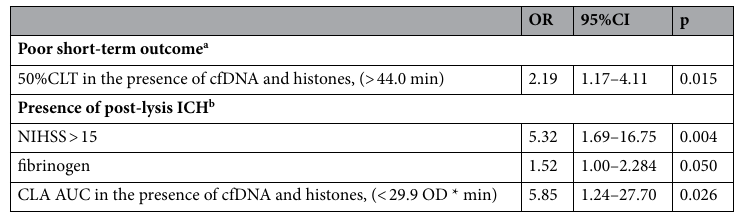
Table 6. Independent predictors of poor short-term outcome and post-lysis intracranial hemorrhage in the studied cohort. Last step of backward multiple regression analysis is provided. cfDNA, cell-free DNA; CLA AUC, clot lysis assay area under the curve parameter; 95%CI, 95% confidence interval; 50%CLT, 50% clot lysis time; ICH, intracranial hemorrhage; NIHSS, National Institutes of Health Stroke Scale; OR, odds ratio. a Poor short-term outcome is defined as a less than 4 points decrease or any increase of NIHSS by day 7 post-event, excluding patients with intracranial hemorrhage. Backward multiple regression model included age, sex, NIHSS on admission, BMI, fibrinogen, D-dimer, plasminogen activity, α2-plasmin inhibitor activity, 50%CLT (threshold: > 45 min) 50%CLT in the presence of cfDNA and histones (threshold: > 44 min), CLA AUC (threshold: > 27.7 OD * min), CLA AUC in the presence of DNA and histones (threshold > 25.4 OD * min). b Backward multiple regression model included age, sex, NIHSS on admission, BMI, history of arterial hypertension, history of hyperlipidemia, fibrinogen, D-dimer, plasminogen activity, α2-plasmin inhibitor activity, 50%CLT (threshold: < 39 min), 50%CLT in the presence of cfDNA and histones (threshold: < 39 min), CLA AUC (threshold: < 28.3 OD * min), CLA AUC in the presence of DNA and histones (threshold: < 29.9 OD *